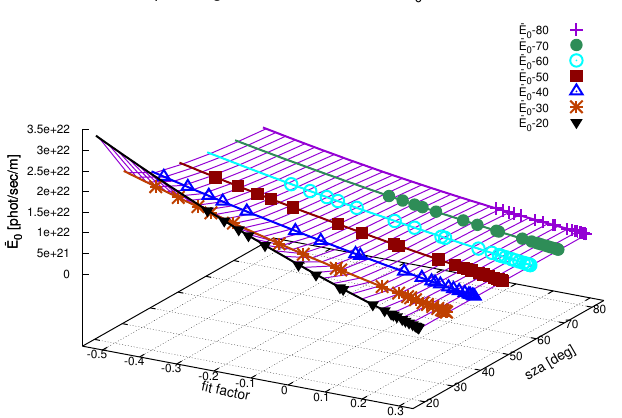
Figure 10. Same relationship as for the reference scenario in Fig. 9 for different SZA in a three-dimensional LUT.